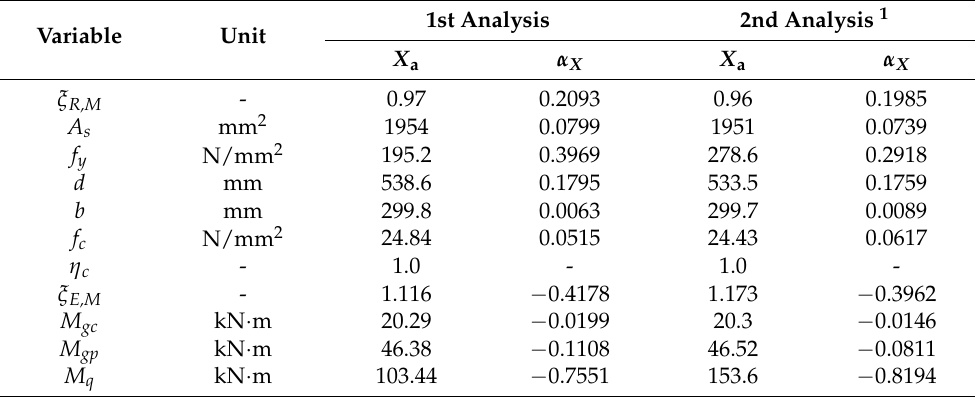
Table 12. Assessment values and sensitivity factors obtained in probabilistic analysis. Variable